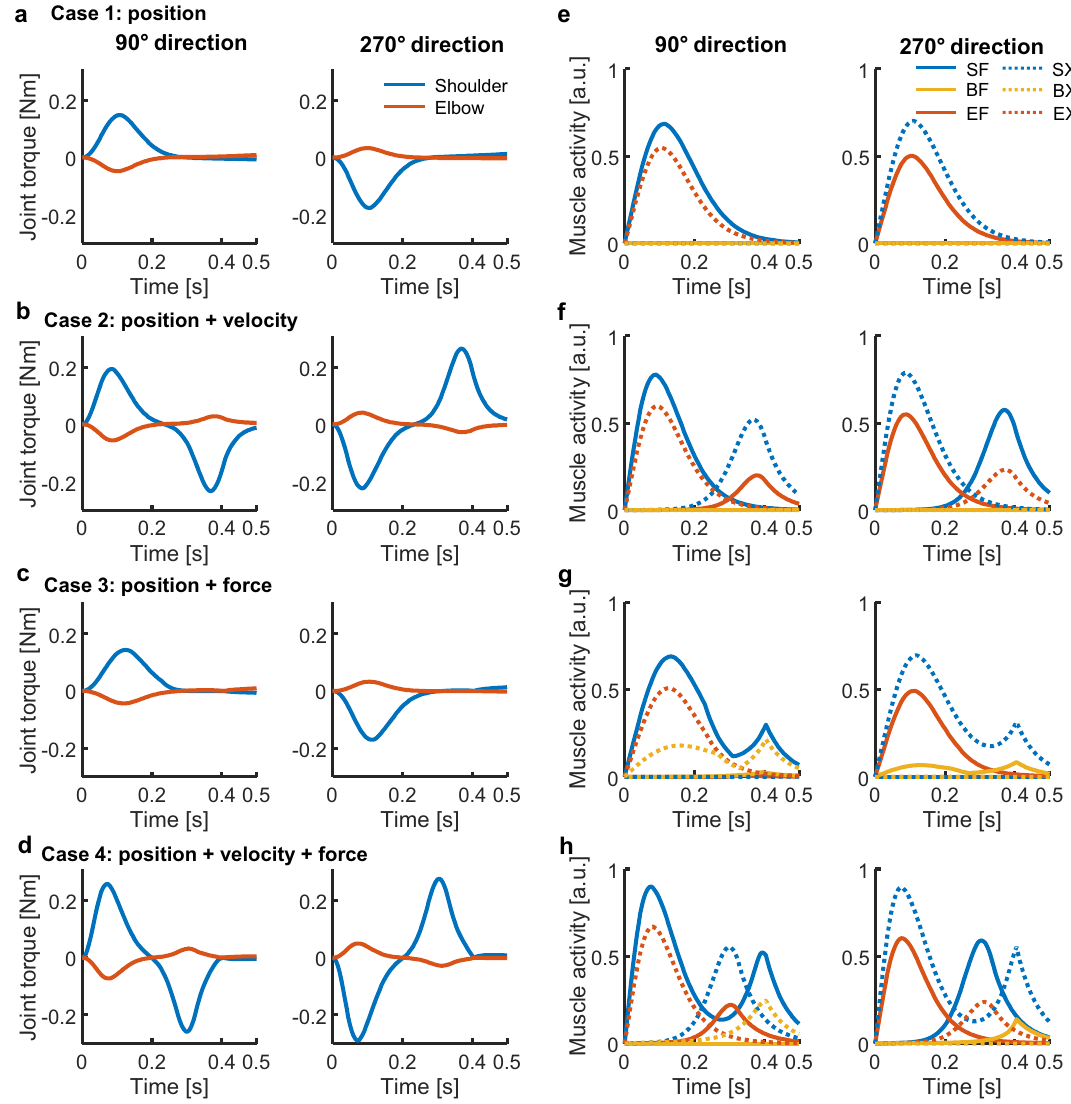
Figure 4. Example of joint torques and muscle activities for forward (90°) and backward directions (270°). Cases 1–4 are in rows from top to bottom, respectively. ( a – d ) Joint torques profiles. ( e – h ) Muscle